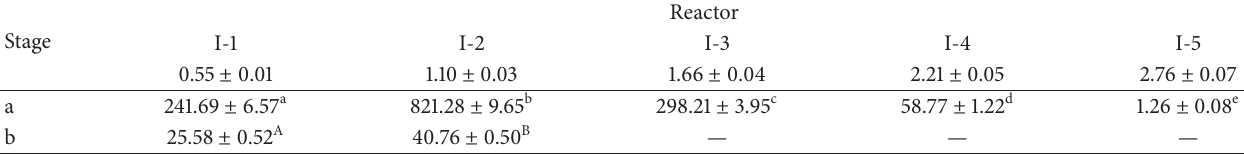
Table 1: Amount of target gene hsp in the inoculated reactors with different inoculum amount.